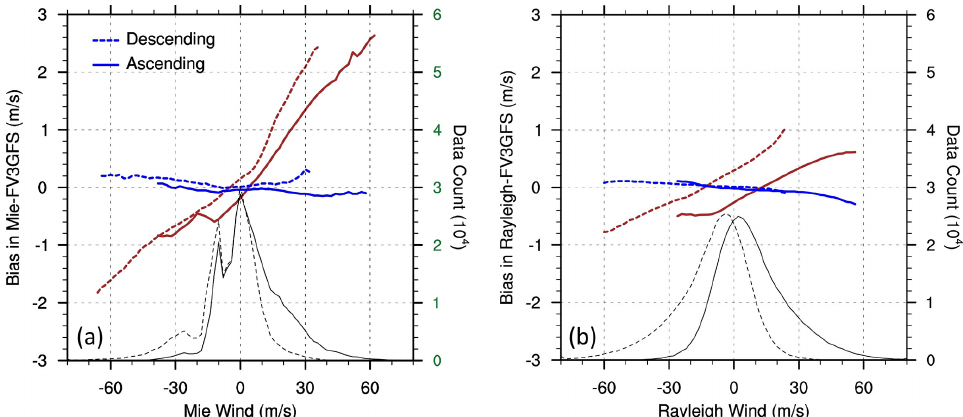
Figure 9. TLS estimated biases (ms − 1 ) before (brown lines) and after (blue lines) TLS bias correction for Mie (a) and Rayleigh (b) winds as a function of the observed Aeolus winds (ms − 1 ), vertically averaged for all latitudes of Aeolus winds. The solid and dashed lines are for ascending and descending orbits, respectively. The black lines report the number of Aeolus winds in each 2ms − 1